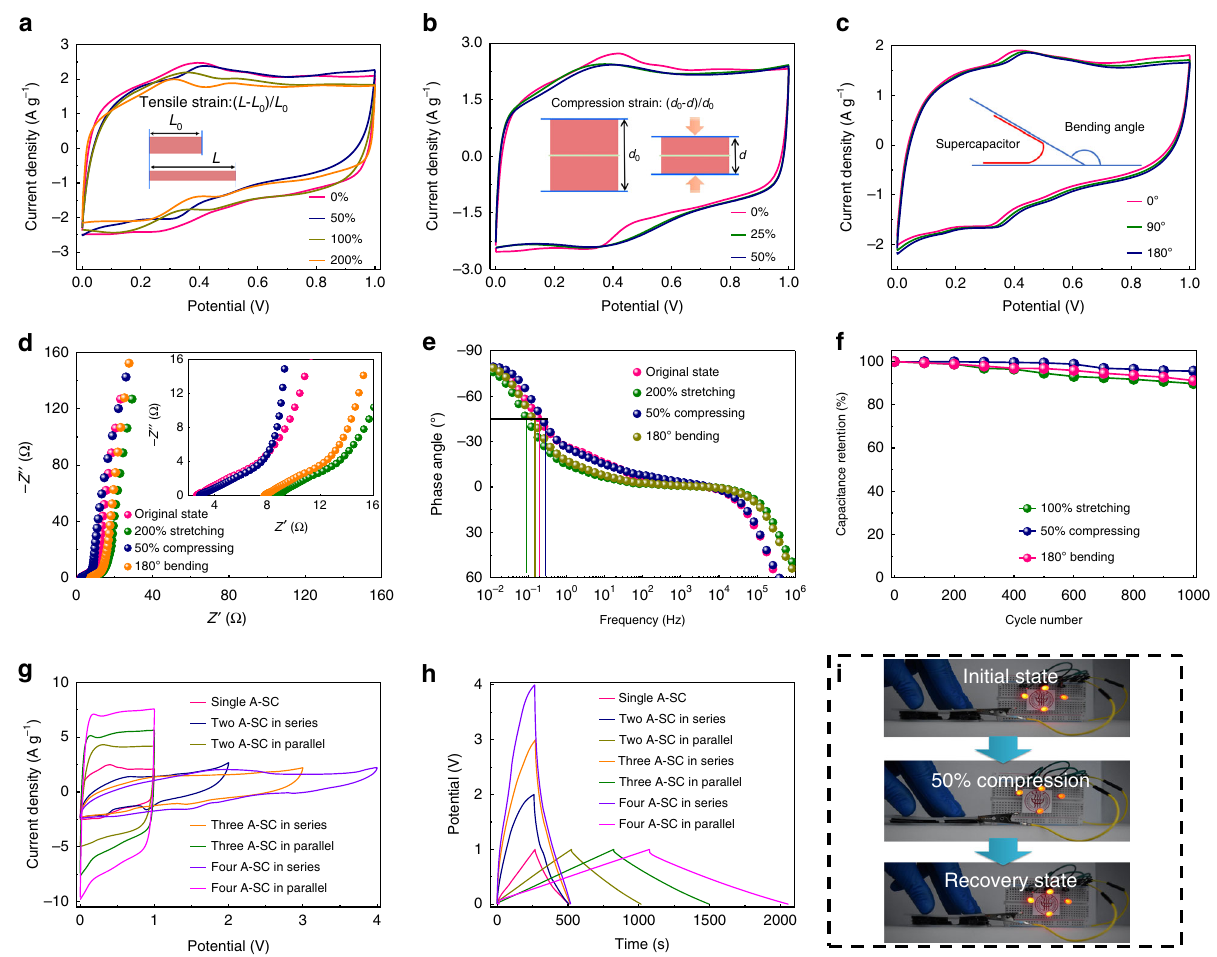
Fig. 6 Performance of all-solid-state supercapacitors under large/complex deformation. Cyclic voltammetry (CV) curves of the all-solid-state supercapacitor (A-SC) under a stretching, b compressing and c bending. Insets in a , b , c demonstrating the de fi nition of tensile strain, compression strain and bending angle, respectively. d Nyquist plots of the A-SC under different deformation states, respectively. Inset of d showing magni fi ed high-frequency region of Nyquist plots. e Bode plots of A-SC under 200% stretching, 50% compression and 180° bending respectively. f Capacitance retention of the A- SC after repeated 100% stretching, 50% compression and 180° bending cycles, respectively. g CV and h Galvanostatic charge/discharge (GCD) curves of one, two, three and four A-SC connected in series and parallel at 10 mV s − 1 and 1 A g − 1 , respectively. i Photographs showing an integrated device with four series-connected A-SC lightening up 4 light-emitting diodes (LEDs) under